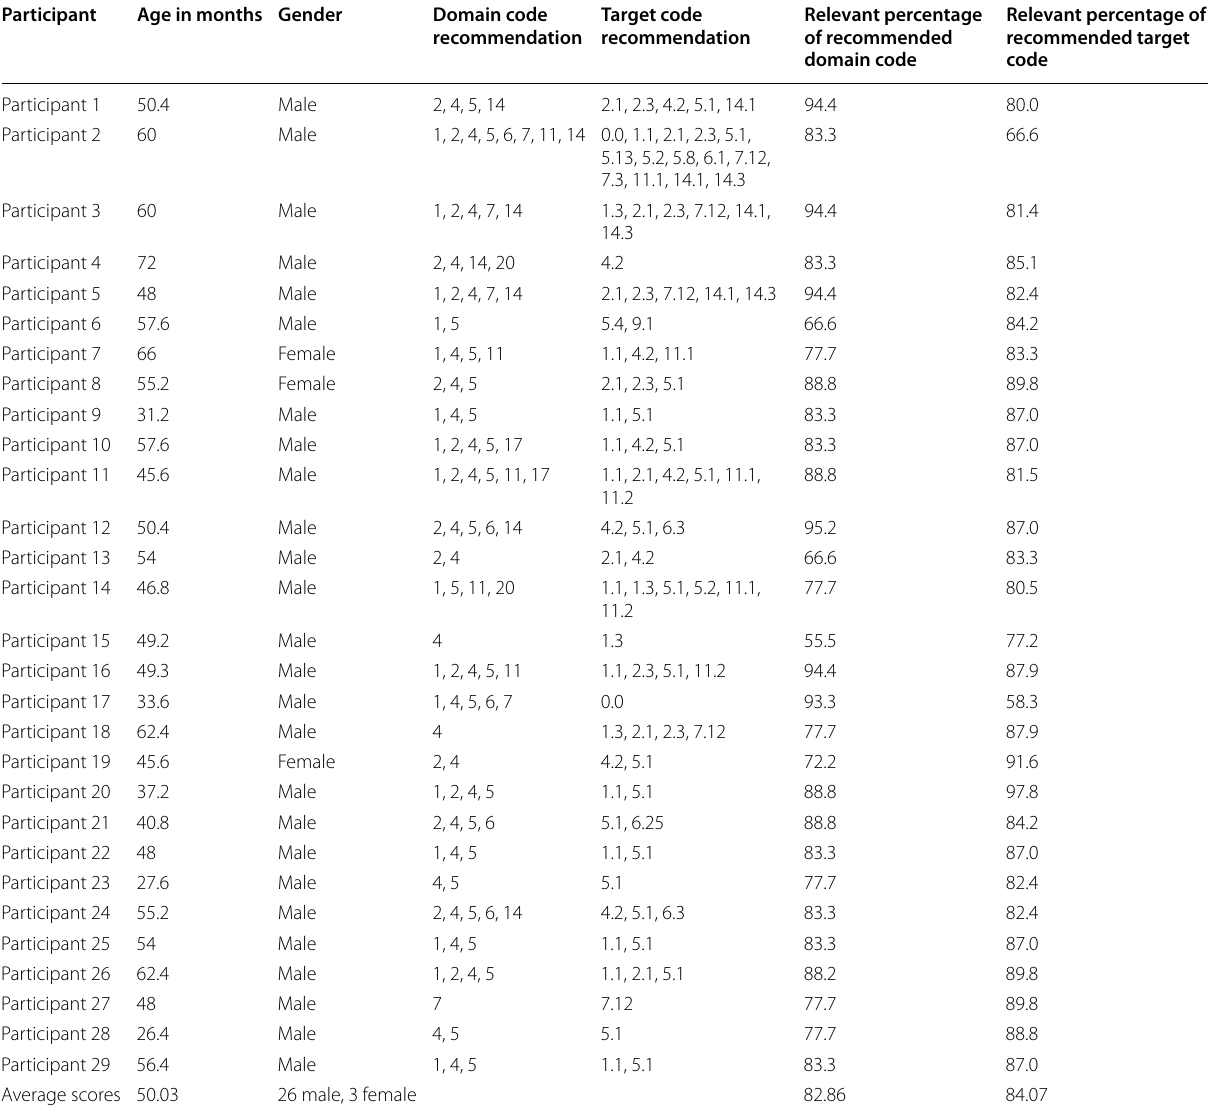
Table 5 Results of patient similarity recommendations for domain and target on commonality measure Participant Age in months Gender Domain code